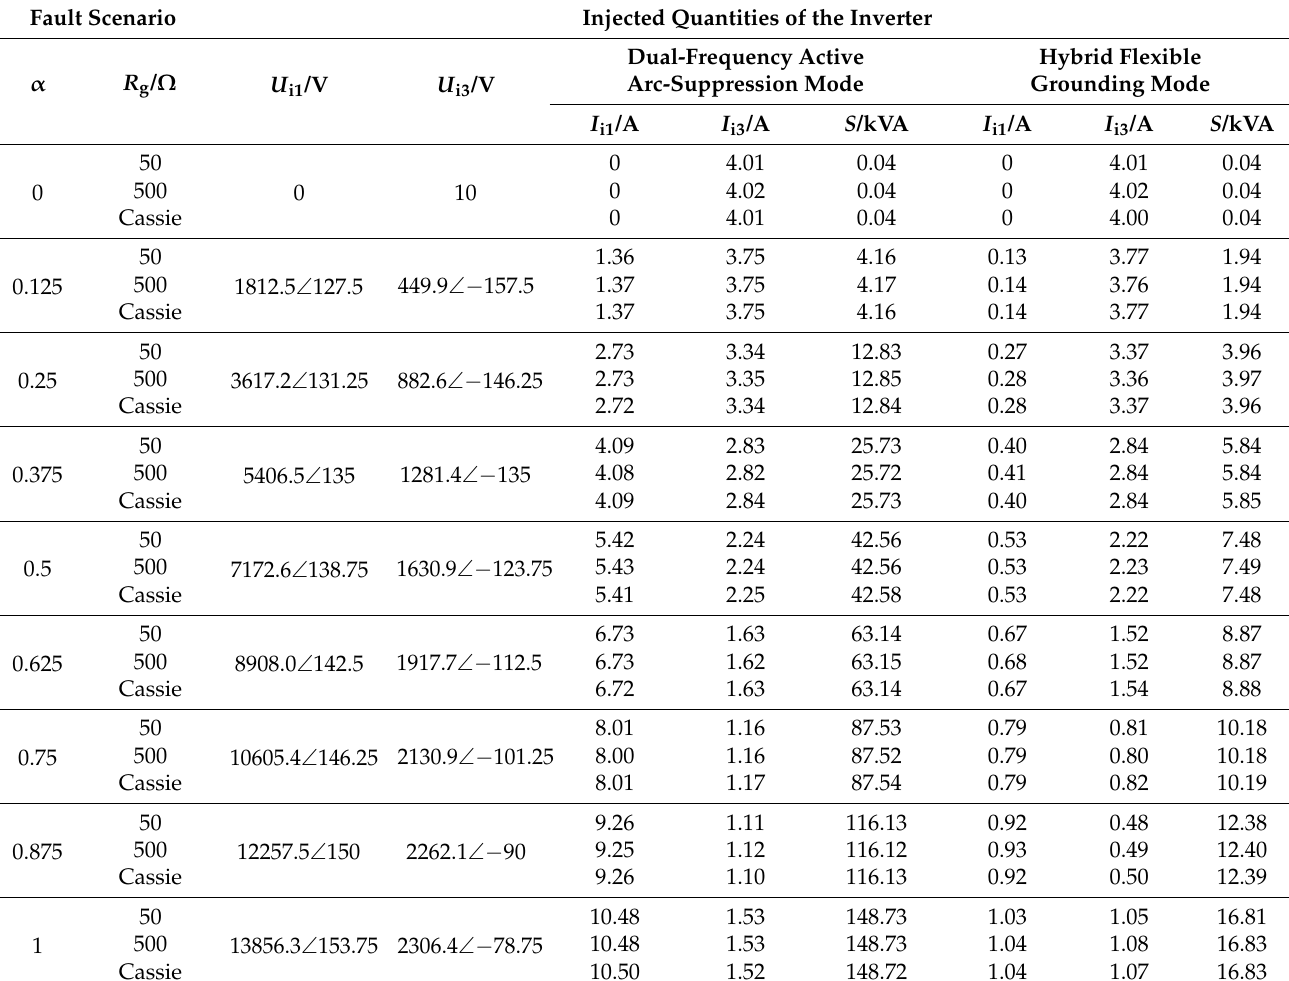
Table 4. Inverter capacity simulation results under different fault